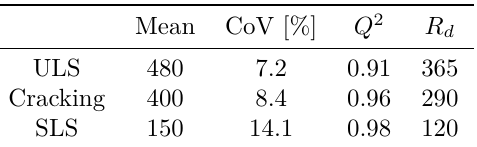
Table 2. Obtained statistical moments and PCE accuracy for each limit